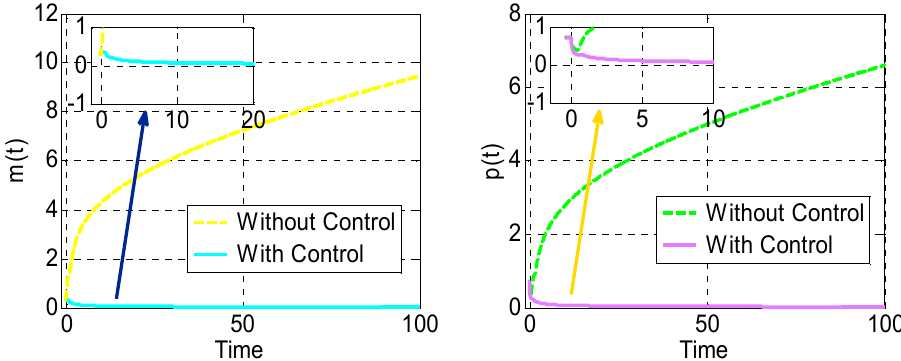
Figure 3. Contrasting time response of the two-dimension FOGRN when α = 0.5.